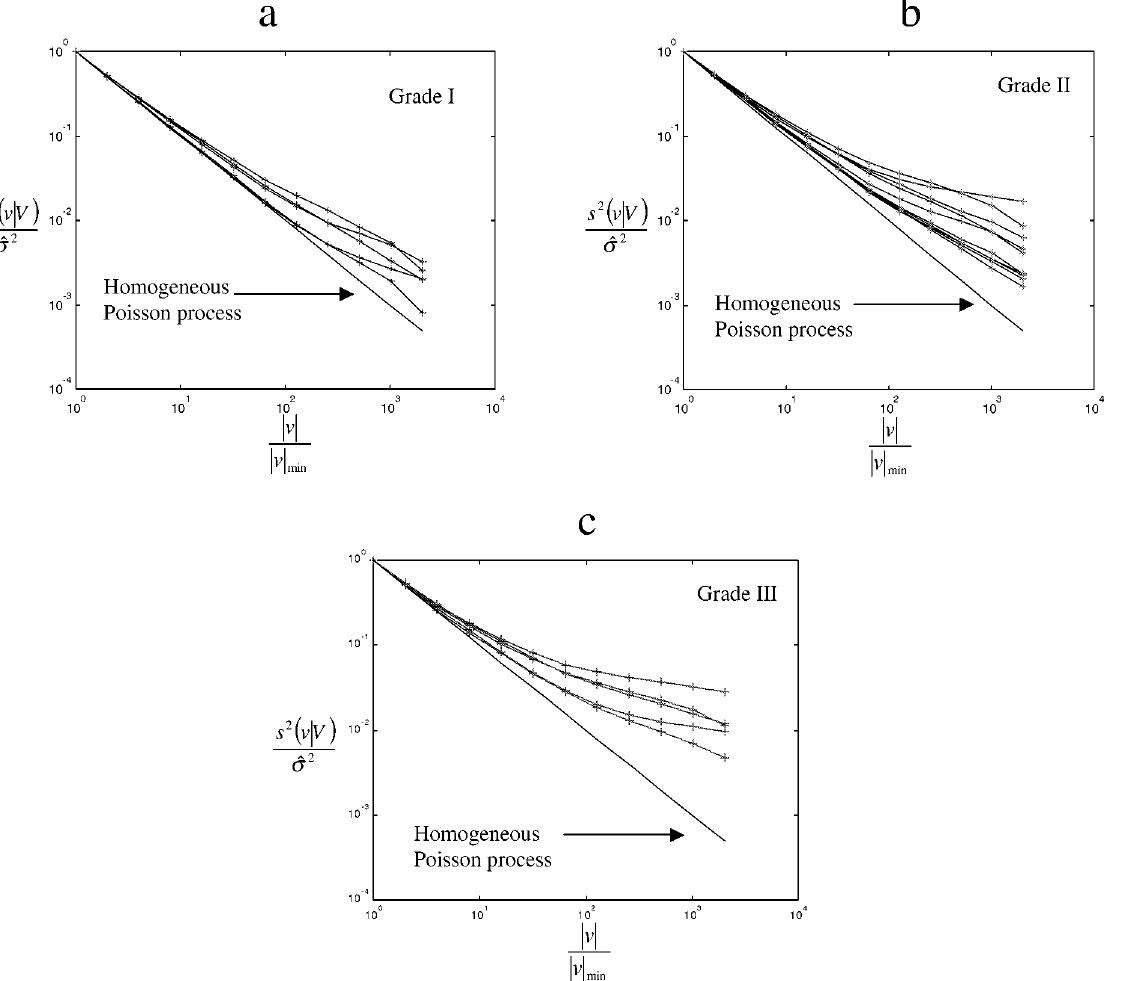
Fig. 3. Logarithmic scaled graphs showing normalised dispersion variance as a function of the size of sub-domains for samples from all: (a) grade I, (b) grade II, and (c) grade III. The homogeneous Poisson process (line with slope − 1) is used as a reference. curve converging to a slope of intermediate value (be- tween 0.75 and